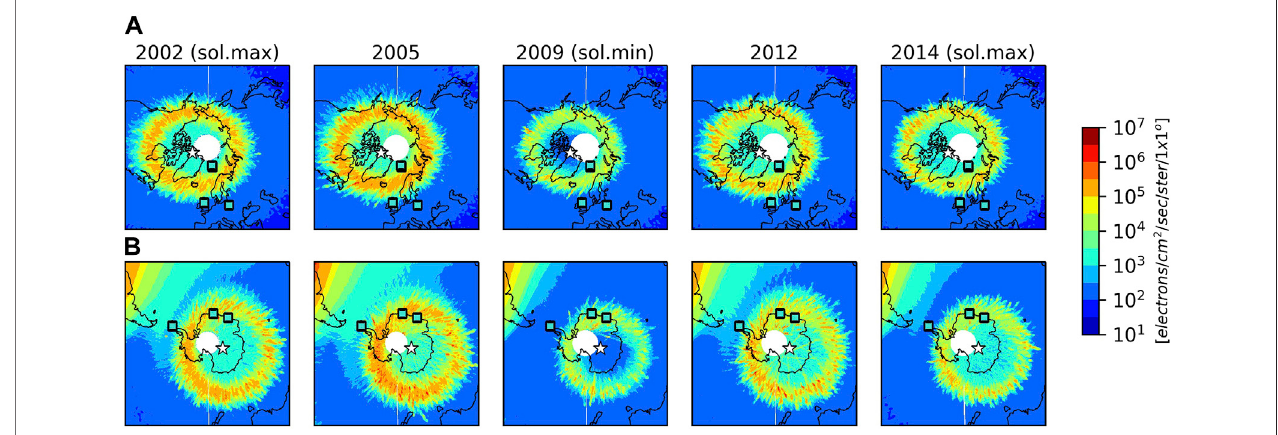
FIGURE7| ComparisonofEEPevents(withrespectivetimeintervalsshadedanddotted)identi fi edinSyowaEastSuperDARNradarmeasurementsbyBlandetal. (2019) and SR intensity records (H EW : orange, H NS : green) for June 14, 2011 (A) and June 23, 2011 (B) . The top row shows the time variation of the AE index (blue) and the radio wave absorption values in the D-region (red) at 10.2 – 10.5 MHz as inferred from the radar measurements. SR intensity records from the SYO, VRN and HRN stationsfortheselecteddays(thickcurves)aredisplayed togetherwiththeaveragediurnalvariationofquietdays(thincurvesinsamecolor)andthecorresponding standarddeviations(same color shaded area) (seethe main textfor more details). Thelast row ofthe fi gure shows Q-factor records fromthe HRN station that tend tobe enhanced during EEP events.